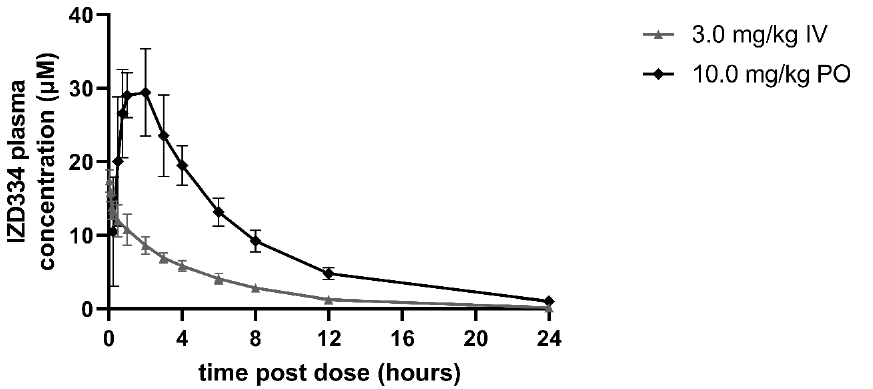
Figure 3. Plasma concentrations of IZD334 in healthy pigs. Concentrations following intravenous (IV) and oral (PO) administration.